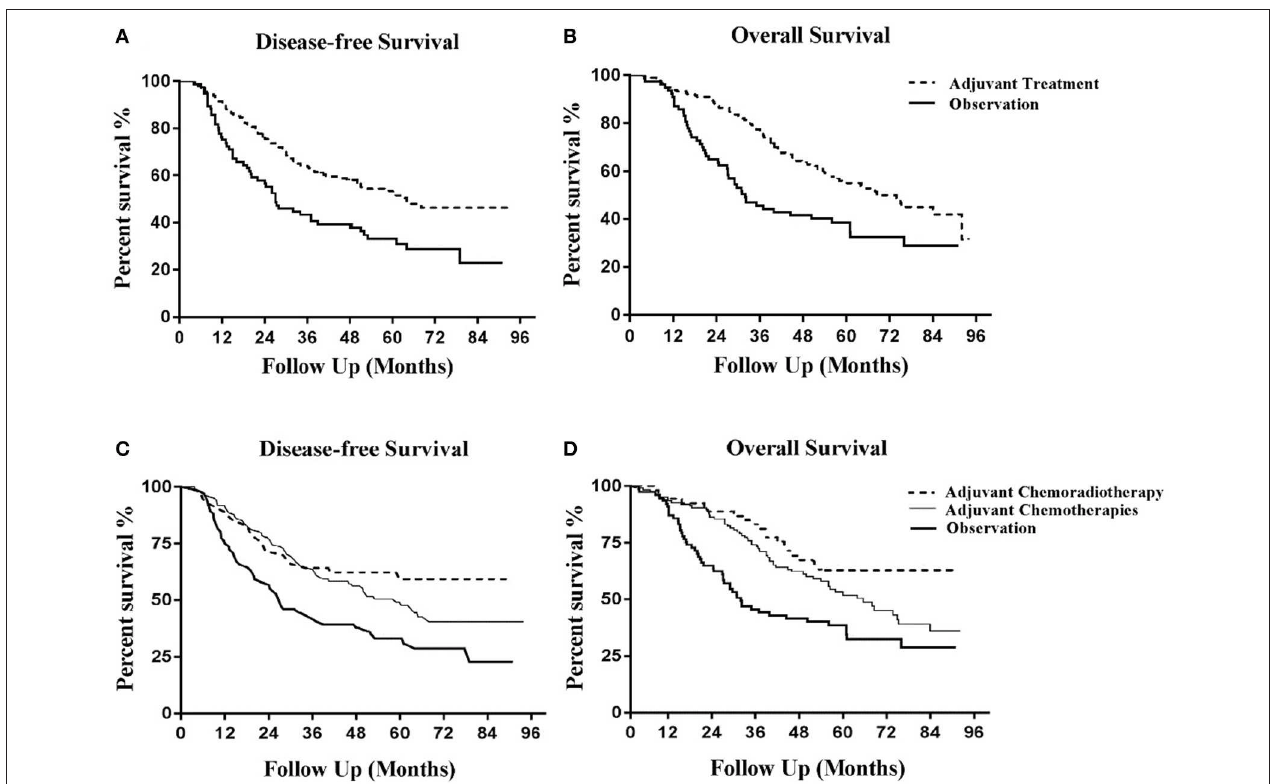
FIGURE 1 | Kaplan-Meier curves of disease-free survival and overall survival. (A) Disease-free survival for adjuvant treatment and observation groups. (B) Overall survival for adjuvant treatment and observation groups. (C) Disease-free survival for adjuvant chemoradiotherapy, adjuvant chemotherapy and observation groups. (D) Overall survival for adjuvant chemoradiotherapy, adjuvant chemotherapy and observation groups.